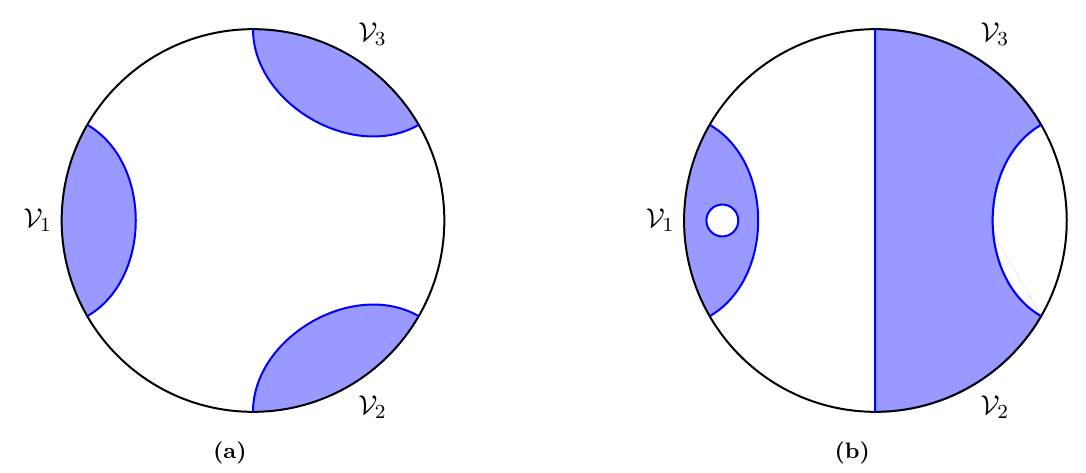
Figure 10. Two examples of disconnected entanglement wedges E V for the case n = 3 , restricted to the maximin slice Σ . In (a) the entanglement wedge has three components. In (b) it has two components; there is one component connecting V a black hole